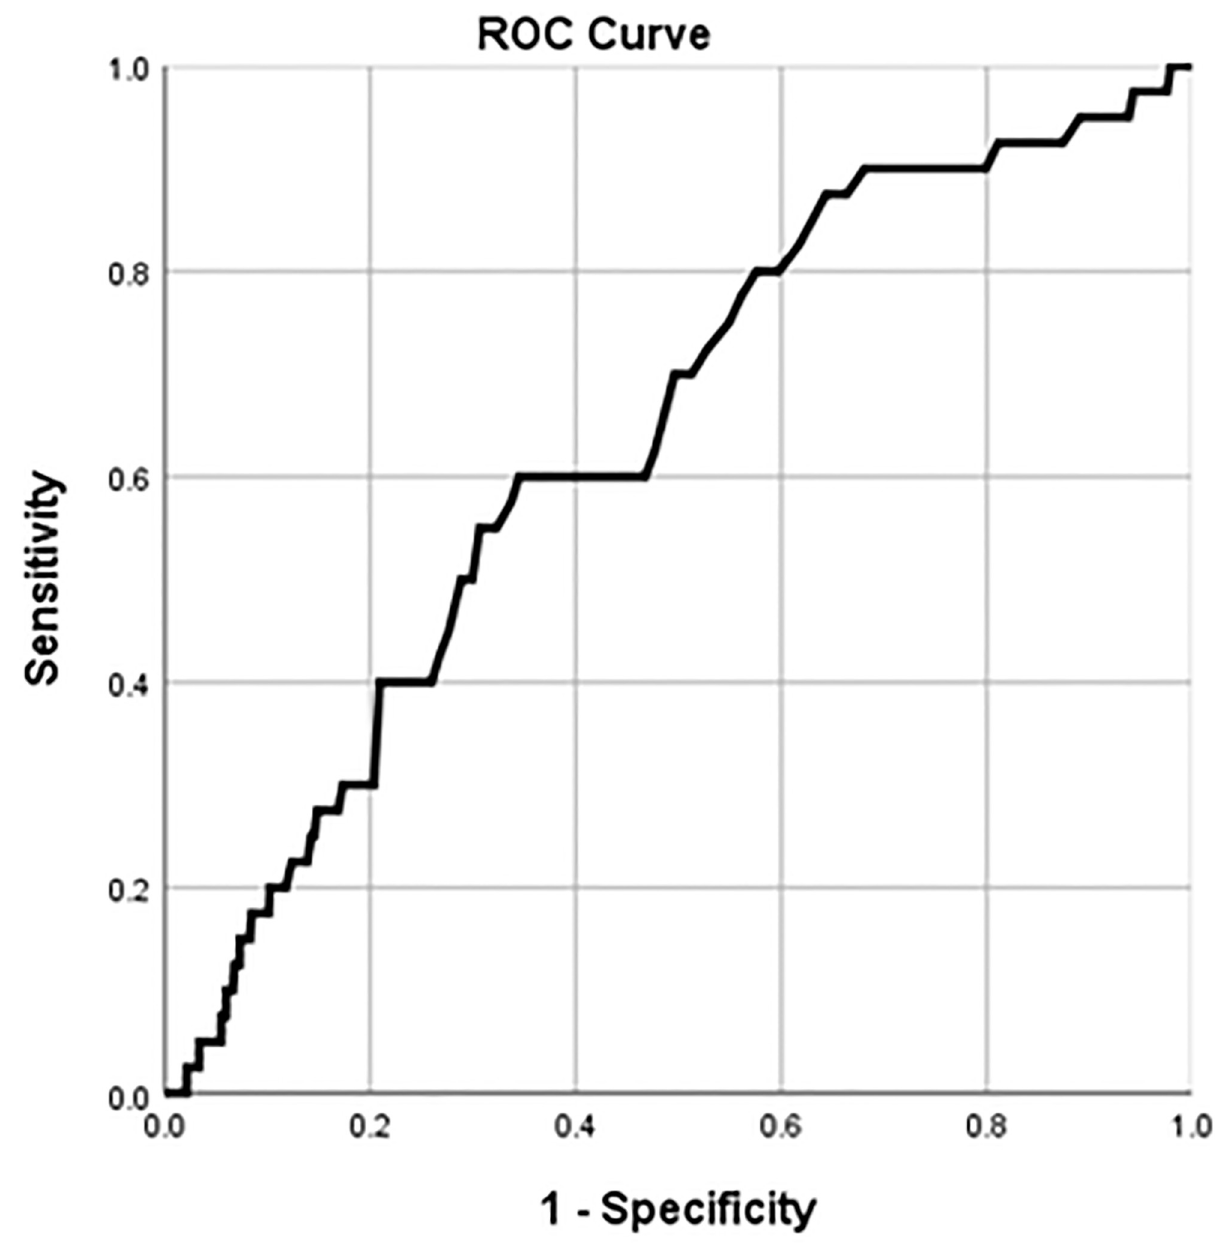
Fig 2. Combined receiver-operating characteristic curve of preoperative serum ALP levels for the incidence of 3-year mortality. The area under the curve = 0.636 and p -value = 0.003 are observed below the line showing the serum ALP level with a 95% confidence interval of 0.554–0.719. The optimal cut-off value of serum ALP that predicted the incidence of 3-year mortality was 71 IU/L, with a sensitivity and specificity of 60.0% and 65.5%, respectively.